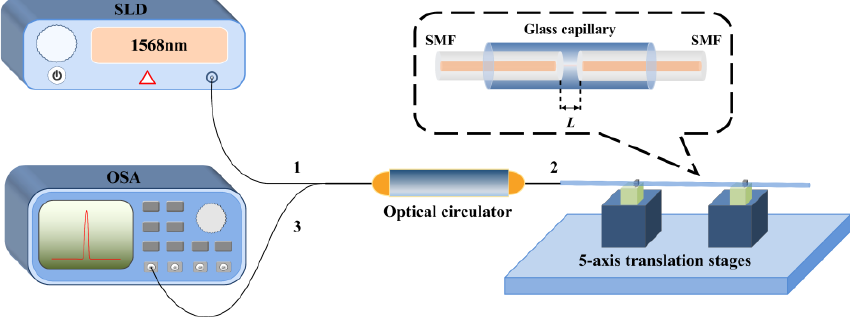
Figure 5. Experimental system for the cavity length demodulation of fiber-optic FP sensors.